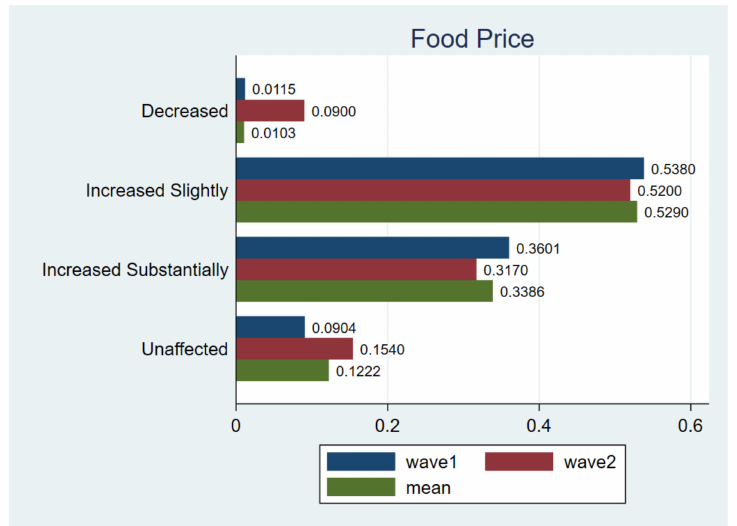
Figure 9. Comparing food price. Notes: t -test for H 0 : equal variance assumed: t value= − 3.1645, Pr (|T| > |t|) = 0.0016; wave1 vs.